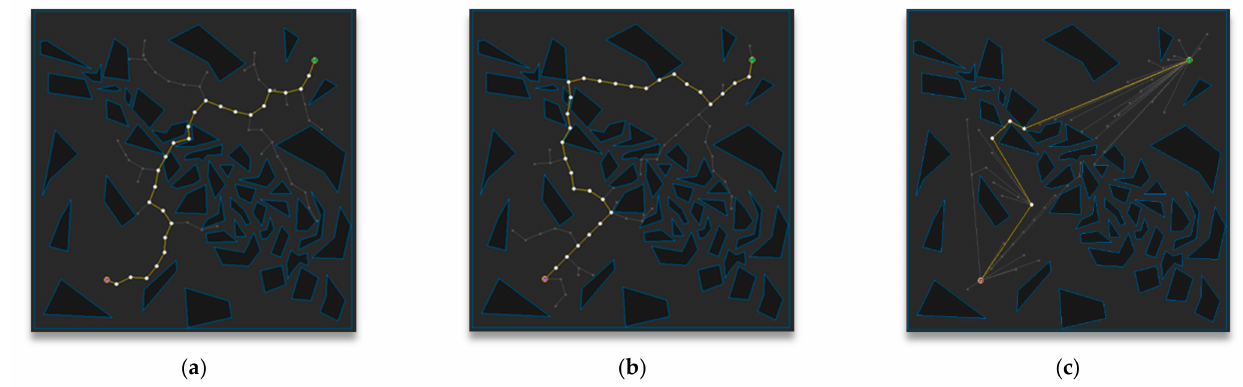
Figure 16. Experimental result of Map 6: ( a ) RRT; ( b ) RRT-Connect; ( c ) the proposed